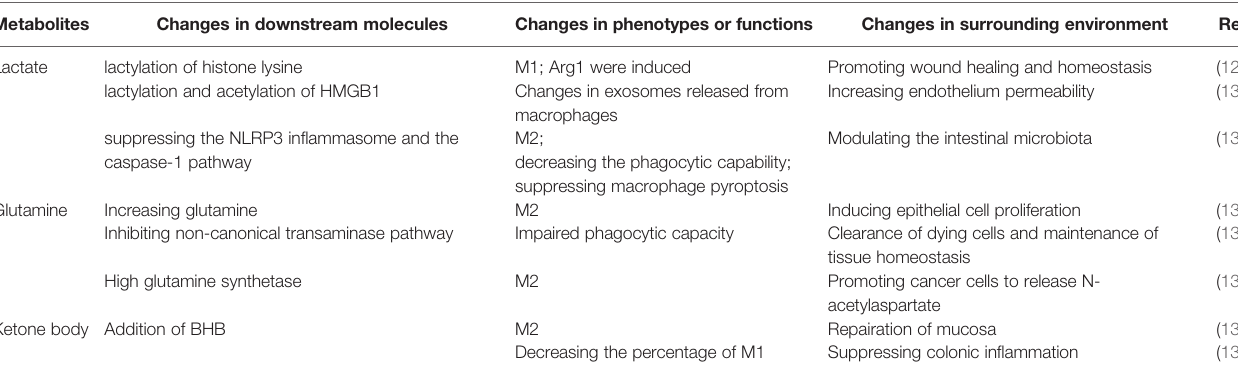
TABLE 2 | Metabolites in shaping the phenotypes and functions of